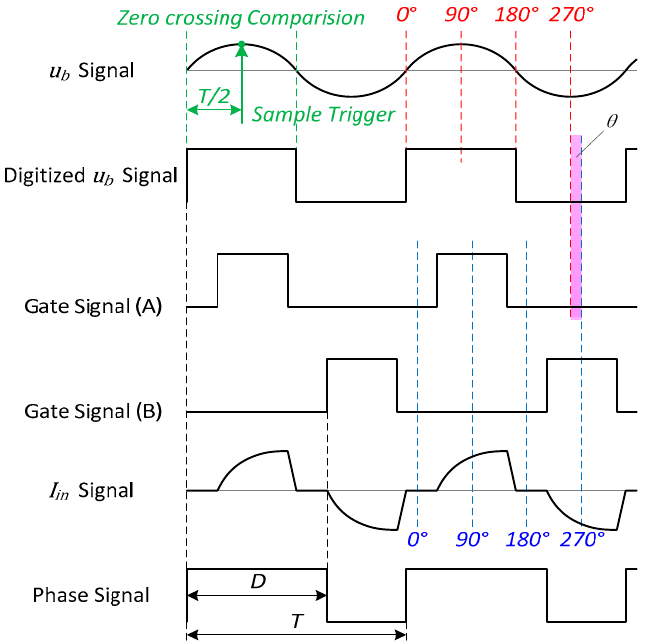
Figure 10. Timing diagram of the relevant signals of pulse-based phase detector (PBPD).